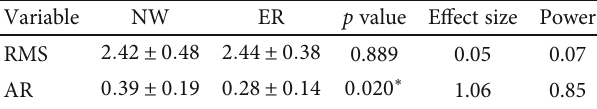
Table 4: Gait parameters calculated from trunk acceleration.